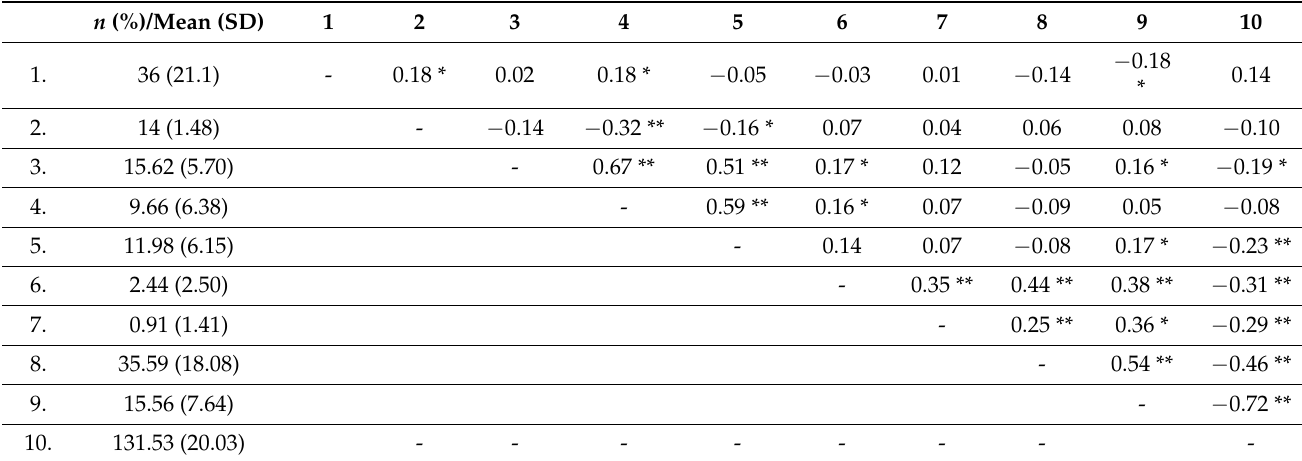
Table 1. Correlation matrix of measured